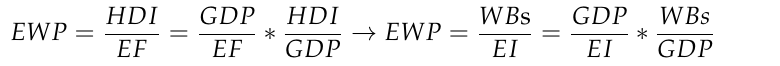
Figure 1. Study area.